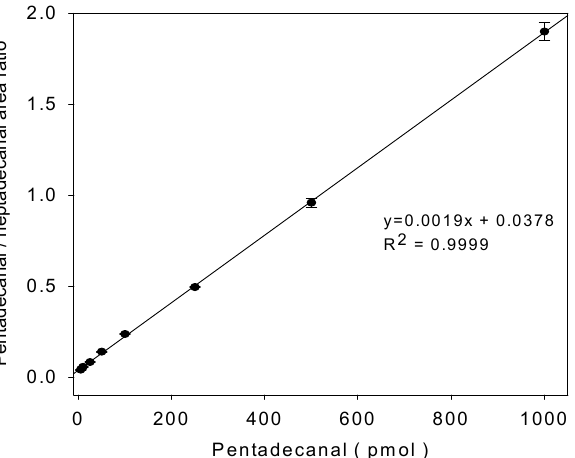
Figure 4. Calibration curve for the quantitation of pentadecanal. We added the indicated concen- trations of the pentadecanal standard to the cell lysates. After the 5,5-dimethyl CHD derivative, we analyzed the SPE extract using C18 reverse-phase HPLC. The fluorescent peak area ratio of pentadecanal versus heptadecanal showed a linear curve with increasing pentadecanal concentrations. The data represent the mean ± SD of triplicate analyses. Table 1. Precision and Accurac y of Pentadecanal in F9-2 Cell Lysates. Component